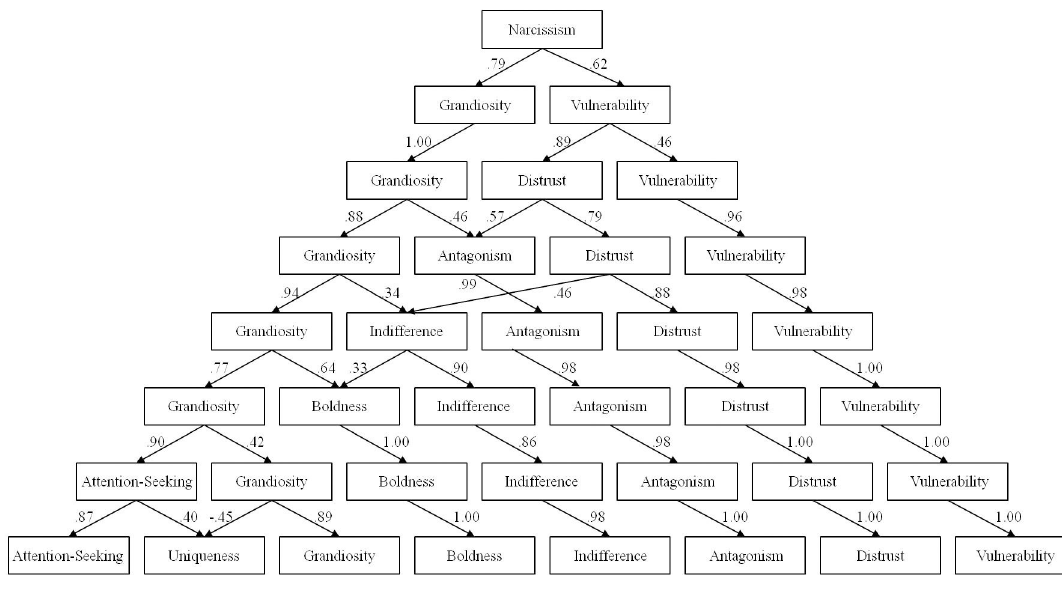
Fig 1. narcissism was at the top of the hierarchy, which split into grandiosity and vulnerability in the second echelon. In the third echelon, vulnerability split to form a more specific vulnerability factor and an unempathic distrust factor. In the fourth, grandiosity split into a more specific grandiosity factor and a self-centered antagonism factor, to which distrust also contributed. In the fifth, a factor resembling indifference to other people emerged from grandiosity and dis- trust. In the sixth, a psychopathic boldness factor emerged from grandiosity and indifference. seeking factor and uniqueness factor.